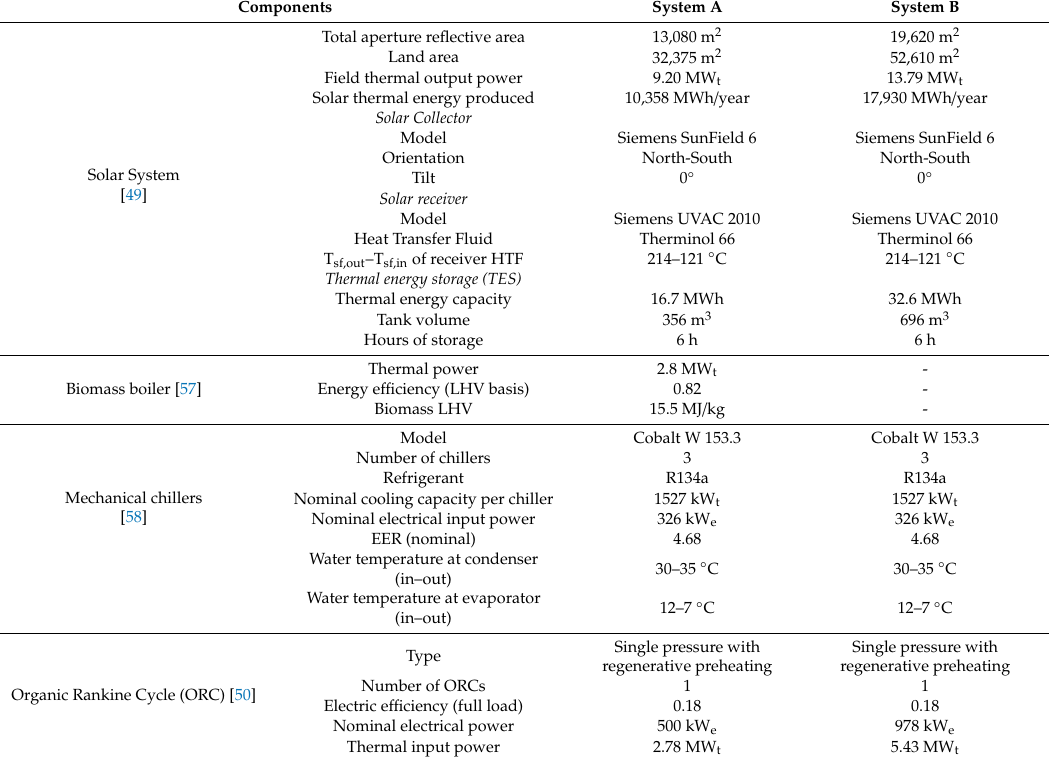
Table 1. Solar-based cogeneration systems. Technical data of components.